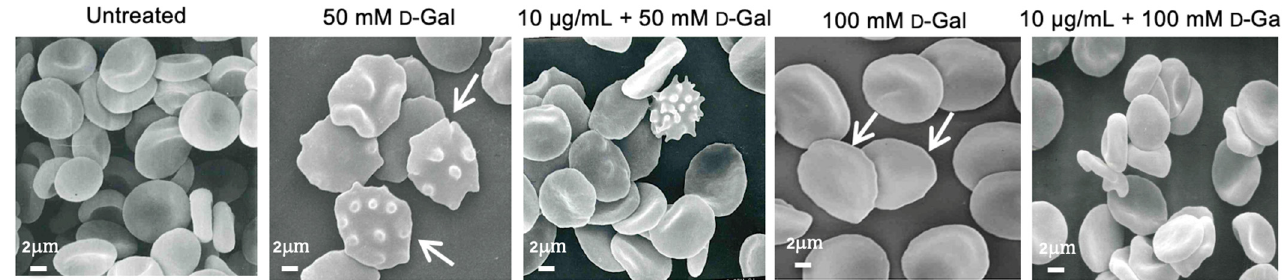
Figure 3. Erythrocyte morphology evaluation. Representative scanning electron microscopy images showing erythrocytes with a typical biconcave form (left untreated); with surface blebs (acanthocytes, arrows) (50 mM D -Gal); with a flattened shape (leptocytes, arrows) (100 mM D -Gal). Pre-treatment with freeze-dried Açaì extract (10 µg/mL) attenuated the morphological changes compared to D -Gal treatment. Magnification 3000×.